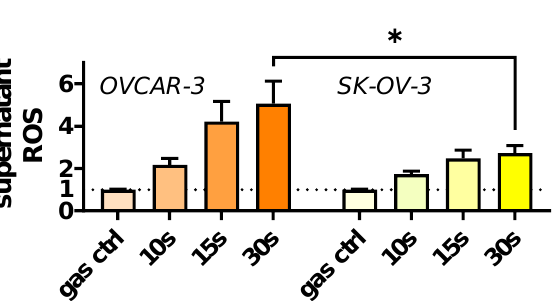
Figure A1. Ovarian cancer supernatant ROS. Ovarian cancer cells were gas plasma-treated for different treatment times (or exposed to argon gas only for 30 s = gas ctrl). Supernatant ROS (H 2 O 2 ) were quantified immediately after using Amplex UltraRed and normalized to gas control values. Data are mean +SEM eight replicates. Statistical analysis was performed using a one-way analysis of variances with p < 0.05 (*).